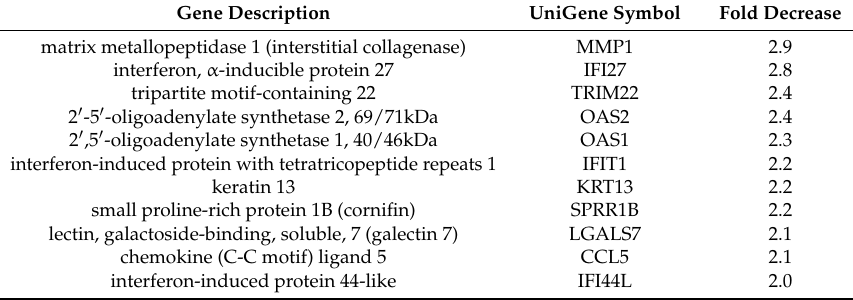
Table 1. List of genes downregulated by gallic acid in nasopharyngeal carcinoma.